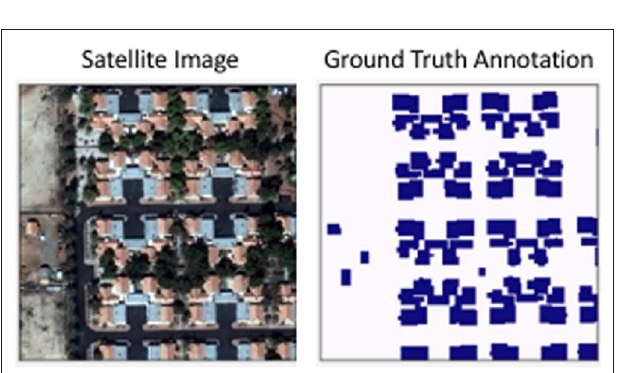
FIGURE 2 | An example of the SpaceNet-Vegas images used in this study. The ground truth annotations for buildings and other structures were professionally